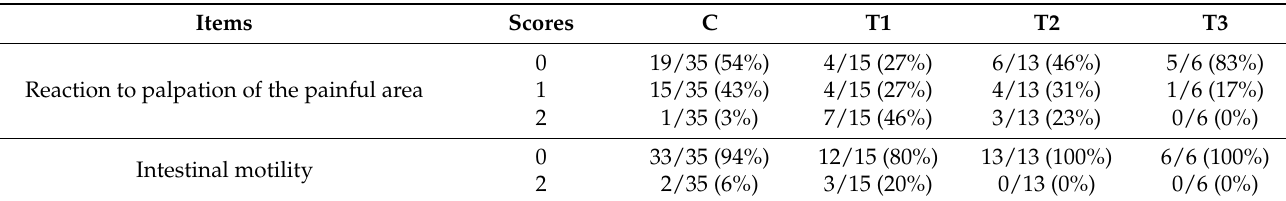
Table 7. Frequency distribution of scores obtained for categorical variables of the Section III (‘reaction to palpation of the painful area’ and ‘intestinal motility’) by group and time points (Control Group at inclusion, C; Pain Group at different time points, T1 = at the inclusion in the study; T2 = after the administration of an analgesic drug; T3 = at recovery). Data are expressed as n